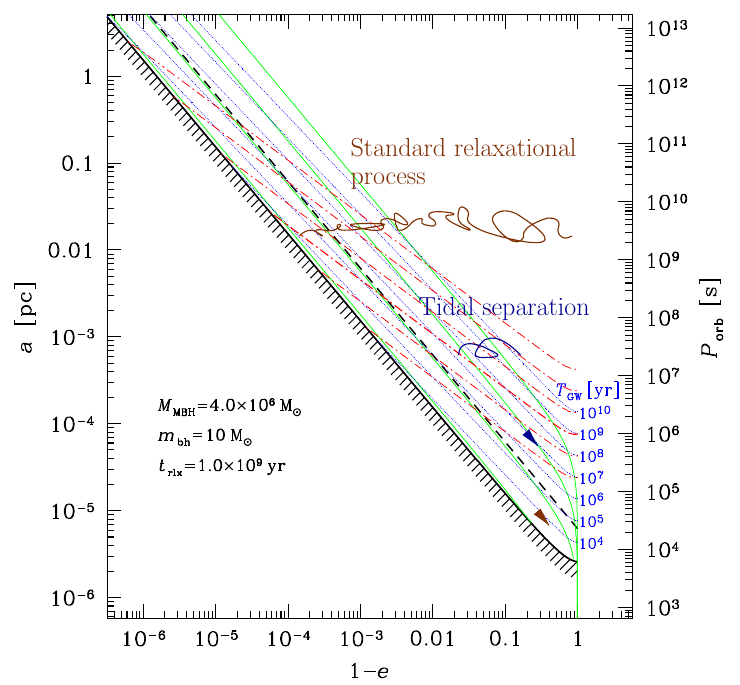
Fig. 43 Capture trajectories in the a – ( 1 − e ) plane and tidal disruption limit. See text for a detailed explanation of the